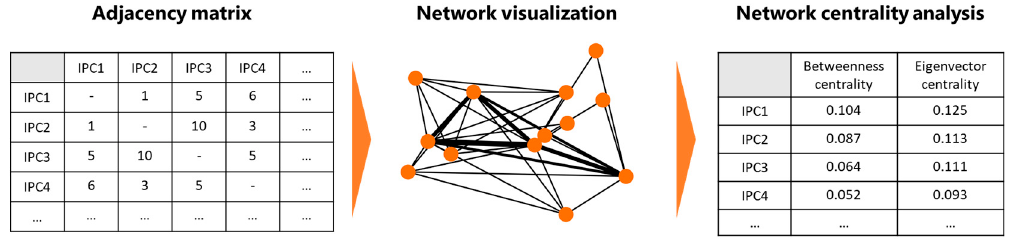
Figure 2. Conceptual flow of network visualization and calculation of centrality metrics. (Note: To simplify the understanding, pseudo-IPC codes have been displayed).